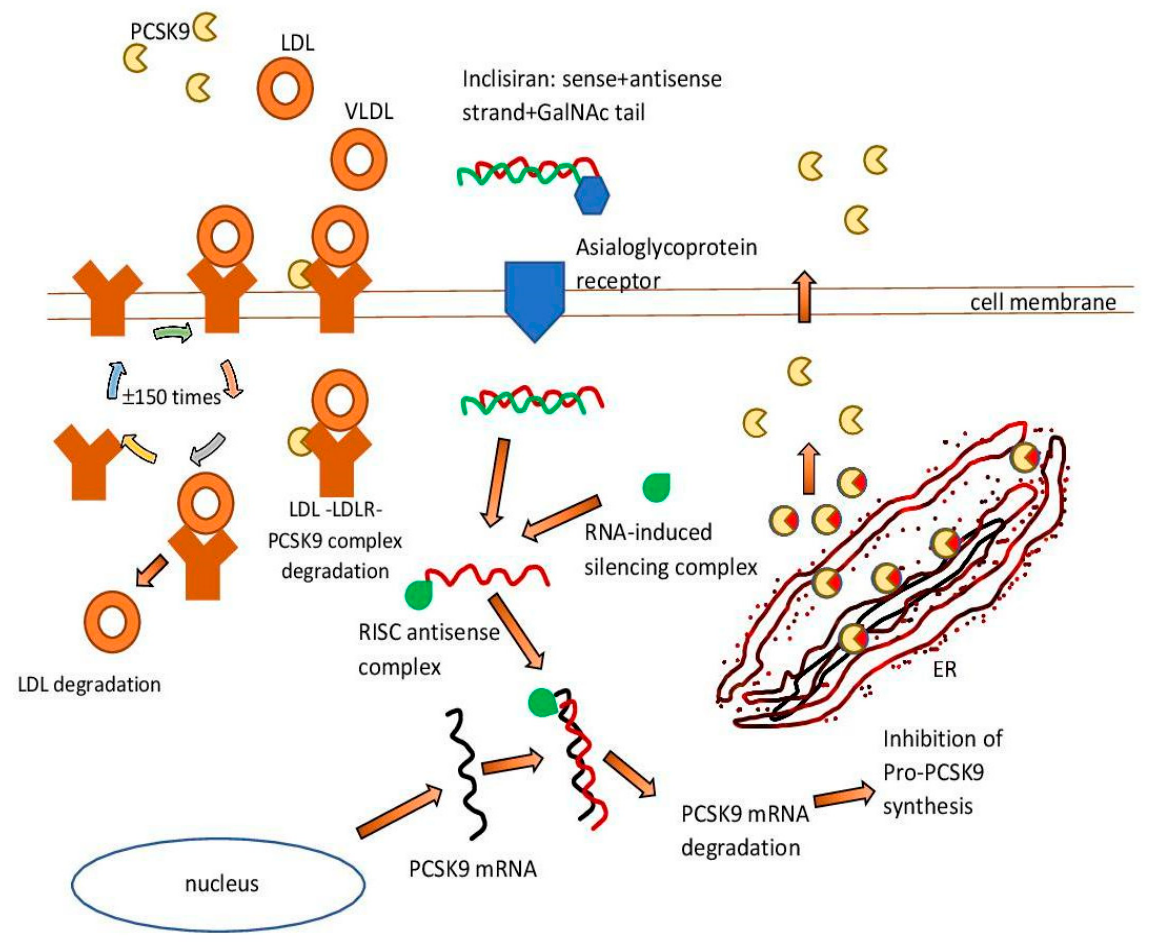
Figure 1. Inclisiran—mechanism of action. ER—endoplasmic reticulum. GAlNAc—N-acetylgalac- Inclisiran—mechanism of action. ER—endoplasmic reticulum. tosamine. LDL—low-density lipoprotein. LDLR—low-density lipoprotein receptor. PCSK9—pro- protein convertase subtilisin/kexin 9. RISC—RNA-induced silencing complex. VLDL—very low- density lipoprotein.